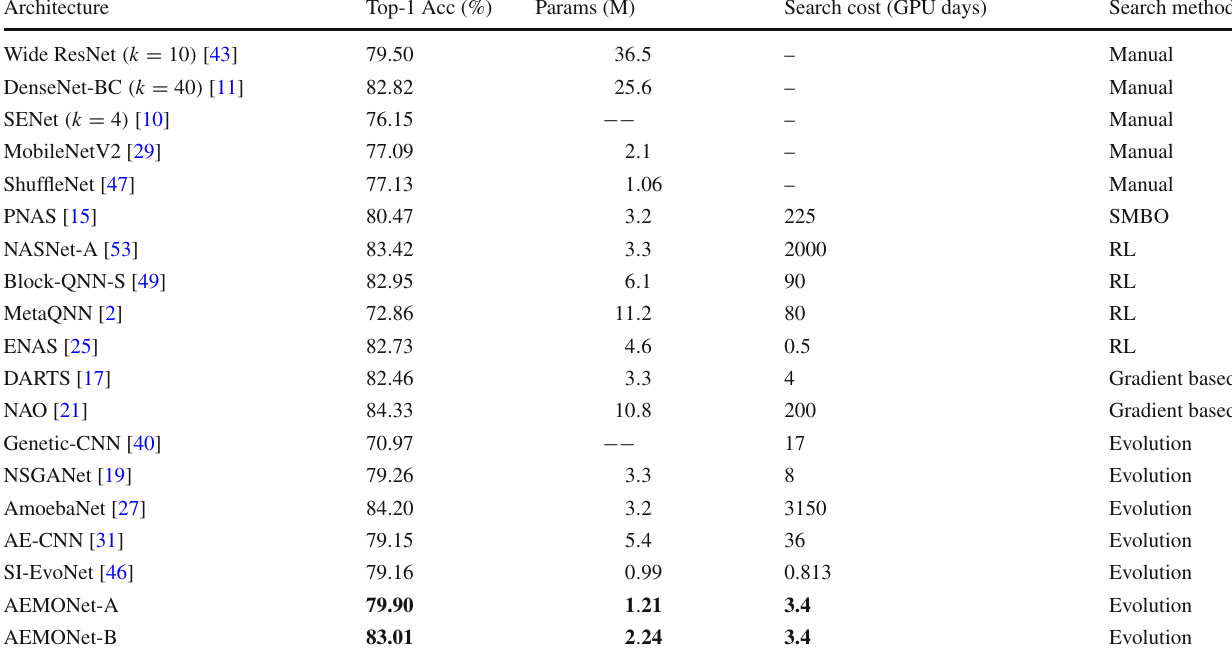
Table 3 The comparison of the proposed AEMONAS and existing peer competitors in terms of Top-1 accuracy and consumed computational cost on the CIFAR-100 datasets